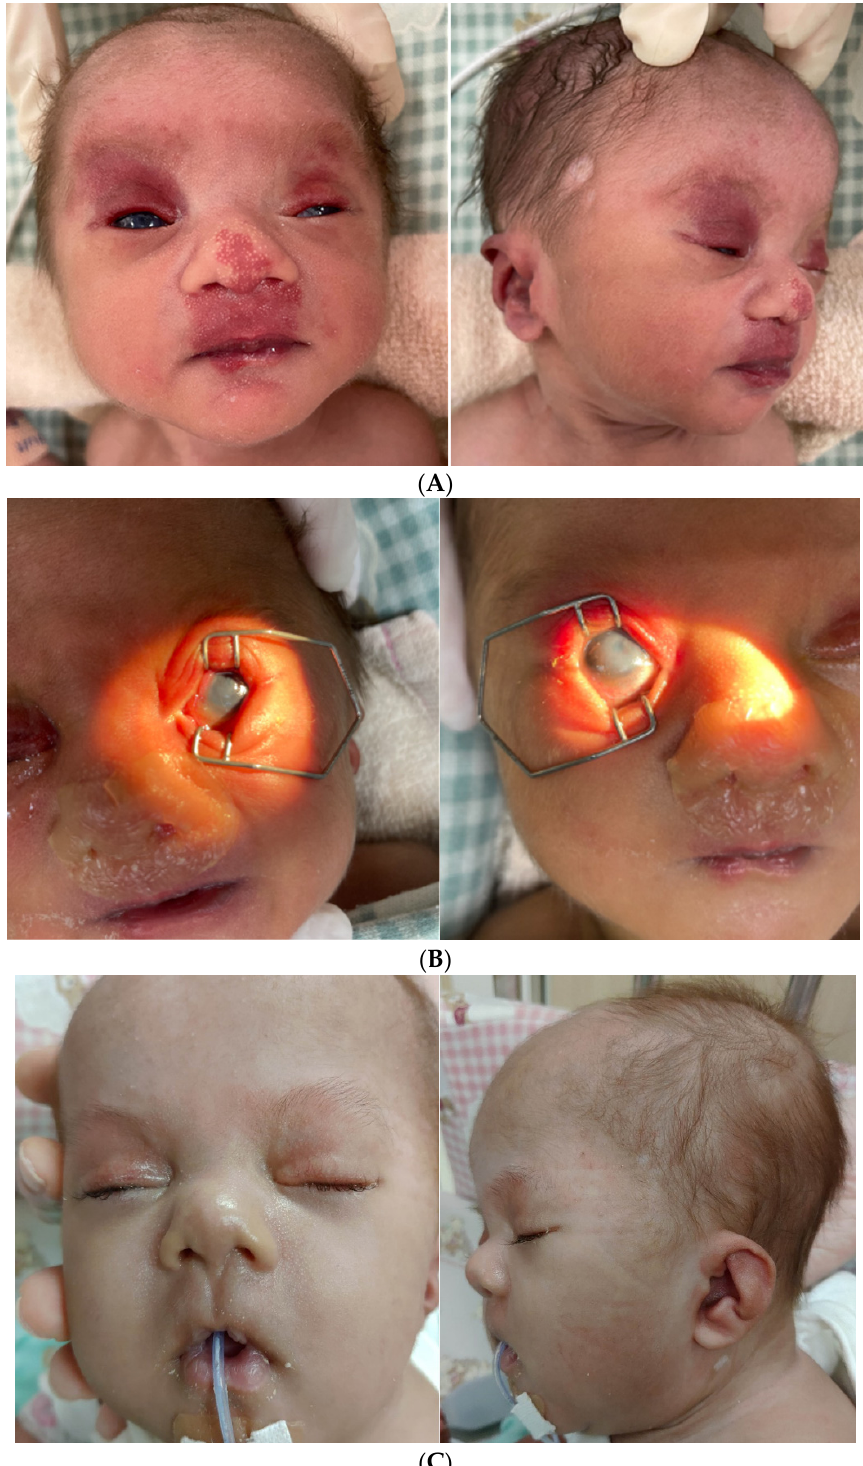
Figure 1. Craniofacial features of our patient. ( A ) At birth, he presented depressed nasal bridge, bulbous nose with prominent columella and bilateral ear lobe crease. Hemangiomas over bilateral upper eyelids, nose tip and philtrum spreading to upper lip. ( B ) At birth, bilateral corneal opacity was also noted. ( C ) The patient’s frontal view and lateral view at 2 months of age. He had depressed nasal bridge, bulbous nose with long philtrum, prominent columella, and left low-set hypoplastic ear.